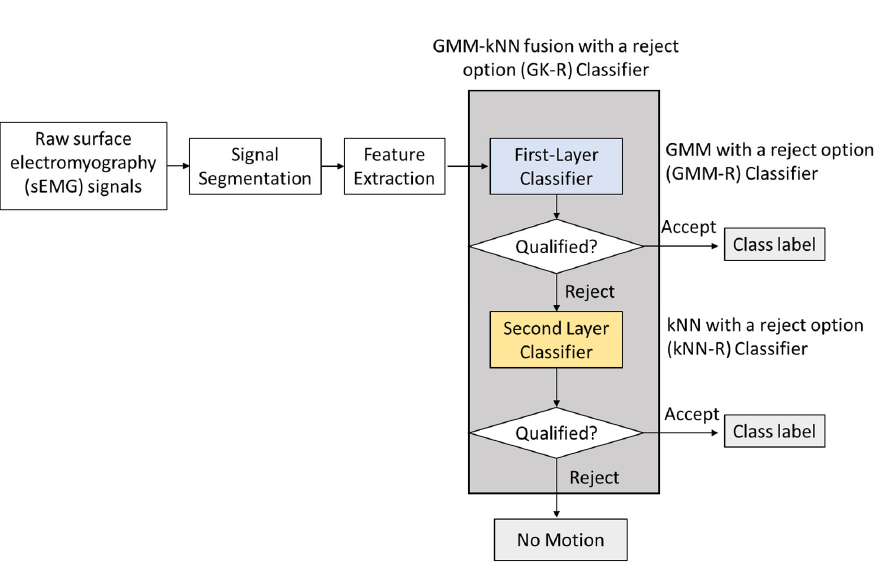
Figure 2. Workflow of proposed classifier.